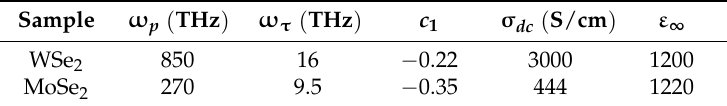
Figure 3. ( a ) Black, red, and blue solid lines represent the time dependent THz signals referred for free space, SiO 2 substrate, and WSe 2 film + substrate, respectively. ( b ) Similar to ( a ), with the blue curve showing the measurement on the MoSe 2 film + substrate. Left and right insets: Comparison between the magnitude T ( ω ) and phase φ T ( ω ) respectively of the transmission function for the two TMD samples. Table 1. Best fit parameters for the dielectric functions of WSe 2 and MoSe 2 films using the DS model. Parameter accuracy is of the order of